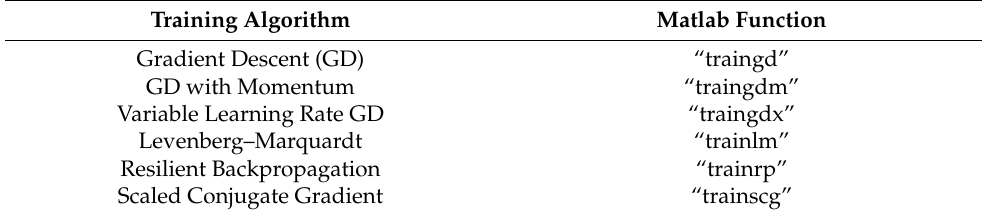
Table 3. Training algorithms used to train the PRN